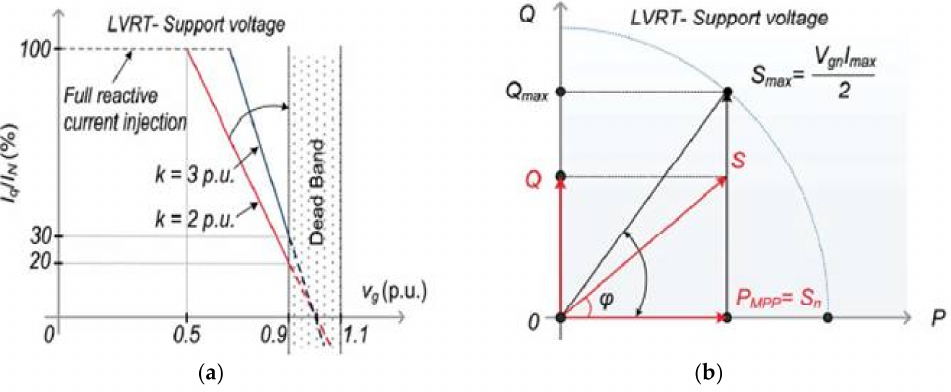
Figure 6. Reactive power profiles for the proposed grid integrated system: ( a ) during LVRT mode for medium- and/or high-voltage systems; and ( b ) reactive power capability of a PV-STATCOM.